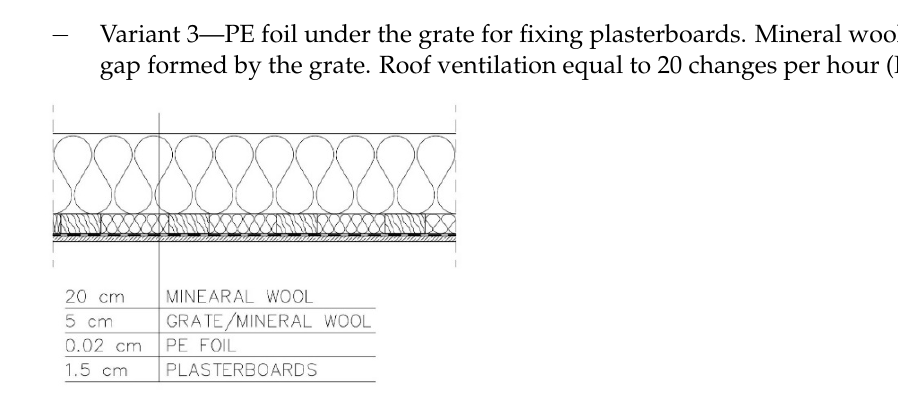
Figure 5. Variant 3: PE foil under the grate for fixing plasterboards. Mineral wool fills the air gap formed by the grate. Roof ventilation equal to 20 changes per hour. − Variant 4—no PE foil in the arrangement of layers. Roof ventilation equal to 20 changes per hour (Figure 6).